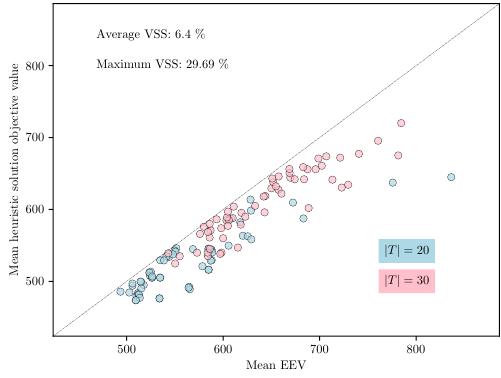
Figure 3. Scatter plot of the mean EEV vs. mean of the estimated solution cost from the heuristic.